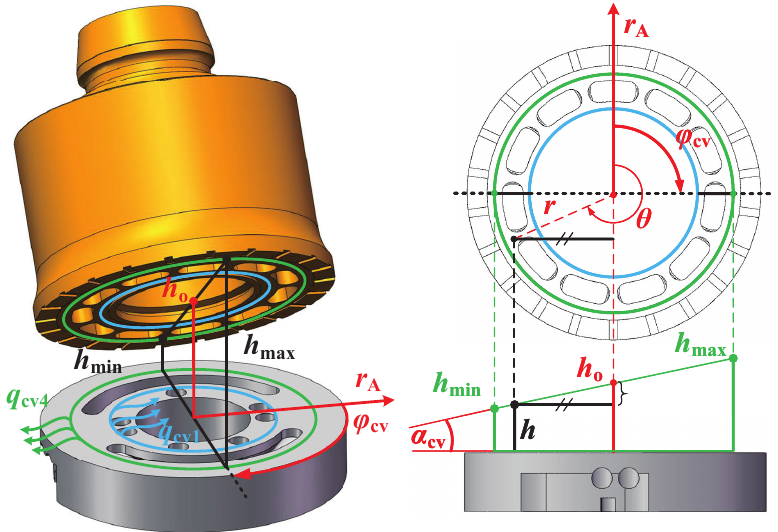
Figure 5. Overturning of the cylinder